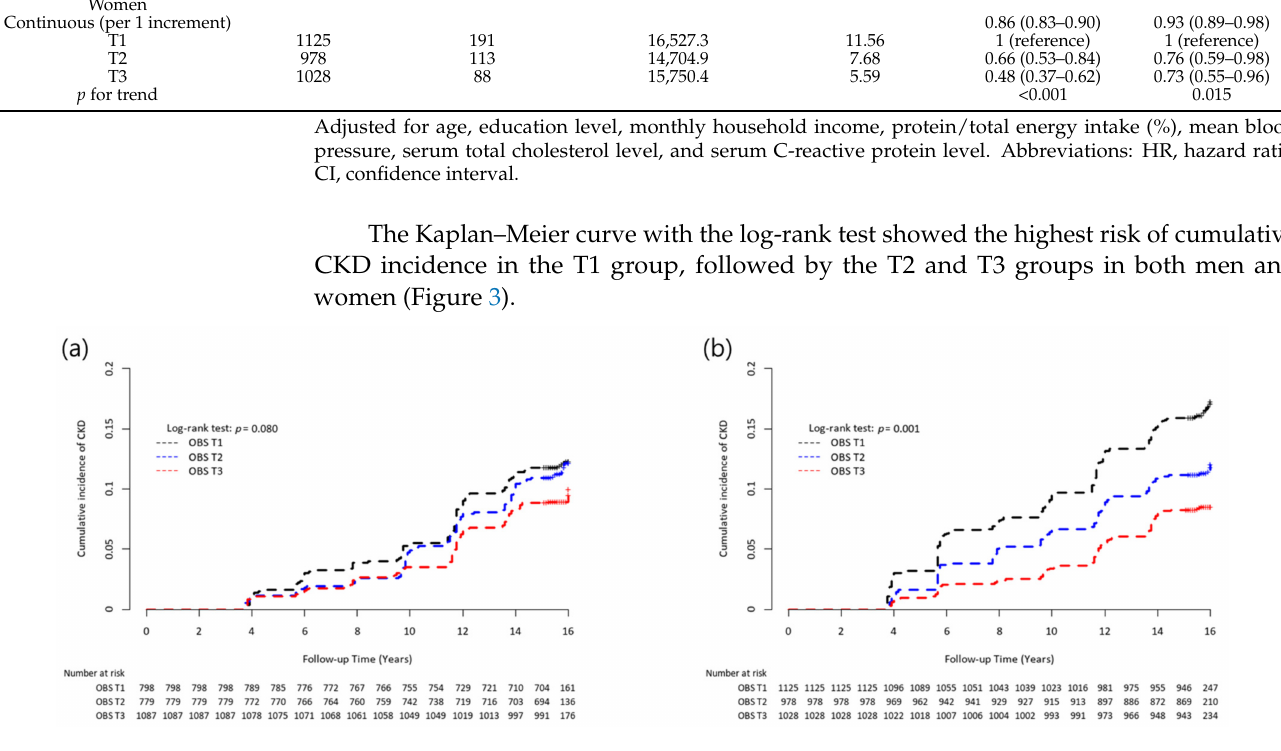
Figure 3. Inverse Kaplan–Meier curves of incident CKD according to OBS tertile groups in ( a ) men and ( b ) women. Abbreviations: CKD, chronic kidney disease, OBS, oxidative balance